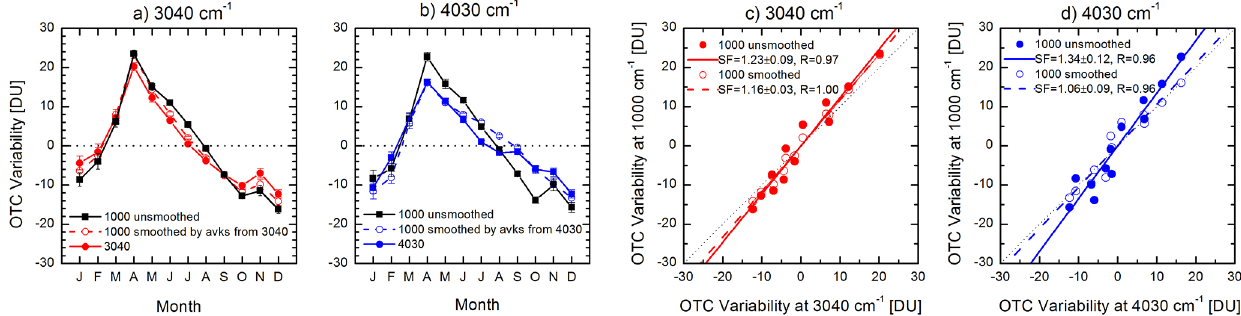
Figure 6. Annual cycle of the OTC variability [DU] for the three spectral regions: (a) 1000cm − 1 unsmoothed, 1000cm − 1 smoothed by the avks from 3040cm − 1 to 3040cm − 1 , (b) same as (a) but for the 4030cm − 1 region. The error bars indicate ± 1SEM. Scatter plots of the OTC variability [DU]: (c) 1000cm − 1 (unsmoothed and smoothed) versus 3040cm − 1 , and (d) same as (c) but for the 4030cm − 1 region (SF = scaling factor). The dotted lines are the diagonals ( x = y ).